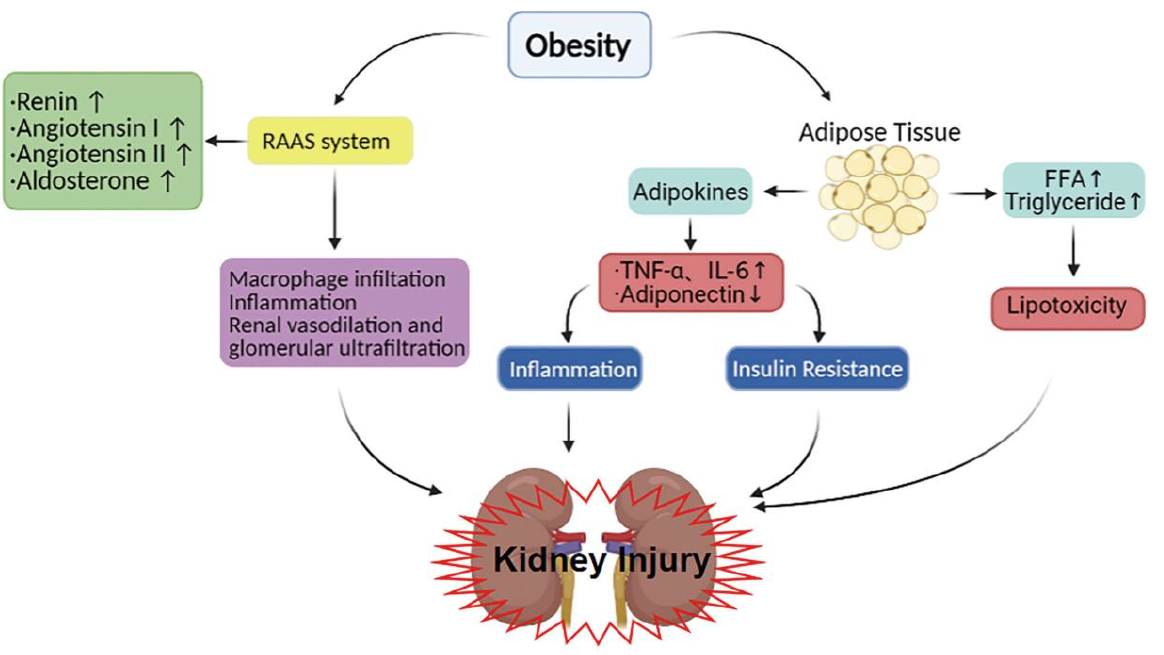
Figure 4. The mechanism by which obesity contributes to kidney injury. In obese individuals, adipose tissue secretes TNF- α , IL-6 and adiponectin. Among them, the pro-inflammatory factor TNF- α , the increase of IL-6 and the decrease of anti-inflammatory factor adiponectin promote the inflammatory response and insulin resistance, and cause the corresponding kidney injury. The lipids in the human body can be roughly divided into cholesterol and neutral fat (triglyceride, phospholipid). Free fatty acid is one of the substances decomposed from neutral fat. When the body is obese, the contents of triglyceride and FFA increase. Then, they are deposited in the kidney, causing toxicity and damage to the kidney and leading to serious lipid metabolism diseases. Similarly, RAAS can also be activated by obesity and promote macrophage infiltration, inflammation, renal vasodilation and glomerular ultrafiltration through a cascade reaction, leading to proteinuria and kidney injury. FFA, free fatty acids; IL-6, interleukin- 6; TNF- α , tumor necrosis factor- α . “ ↑ ” represents an increase, and “ ↓ ” represents a decrease.